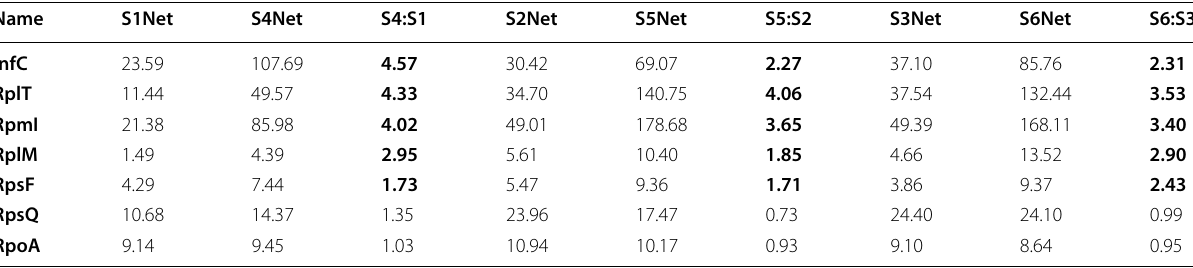
Table 2 The expression levels of the seven common proteins in Fig.